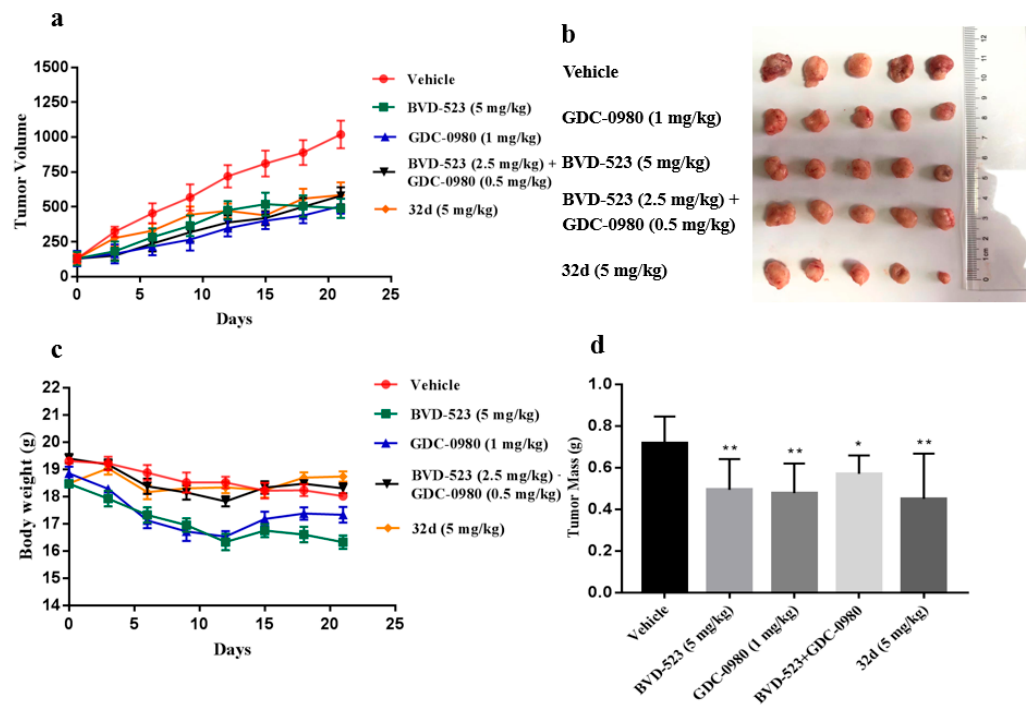
Figure 6. Antitumor efficacy of 32d in the HCT-116 mouse xenograft model. ( a ) HCT-116 mousexenograft data with compound 32d . ( b ) The resulting tumors were excised from the indicated groups. ( c ) The nude mouse body weight was measured every 3 days. ( d ) The tumor masses for five groups of animals were compared, and each histogram represents the Mean ± SD of 6 mice. * p < 0.1, ** p < 0.05 vs. control.